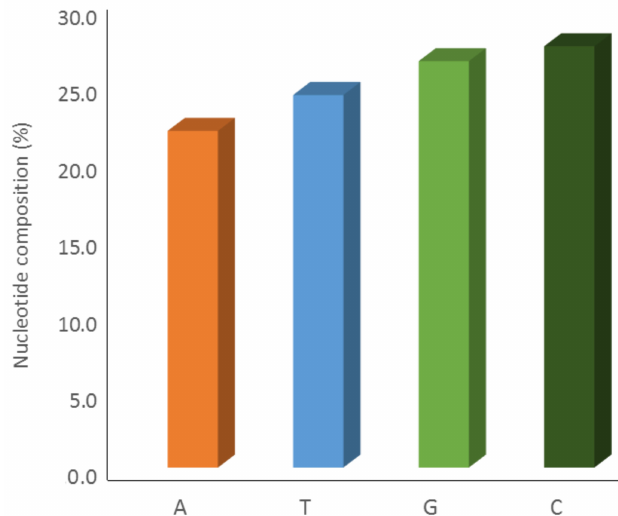
Figure 2. Nucleotide compositions of the 30 haplotype sequences in data set.